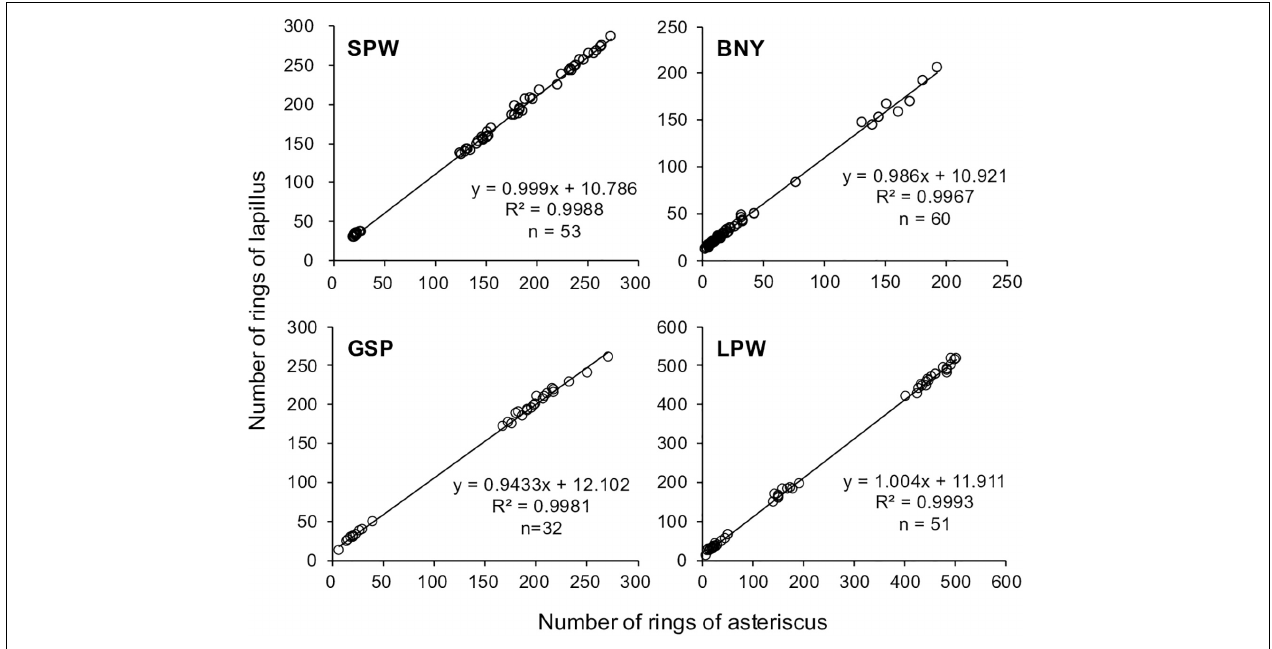
FIGURE 5 | Number of rings read from both the asteriscus and lapillus and the linear relationship between the two numbers, for spotwing flyingfish (SPW), bony flyingfish (BNY), greater spotted flyingfish (GSP), and limpidwing flyingfish